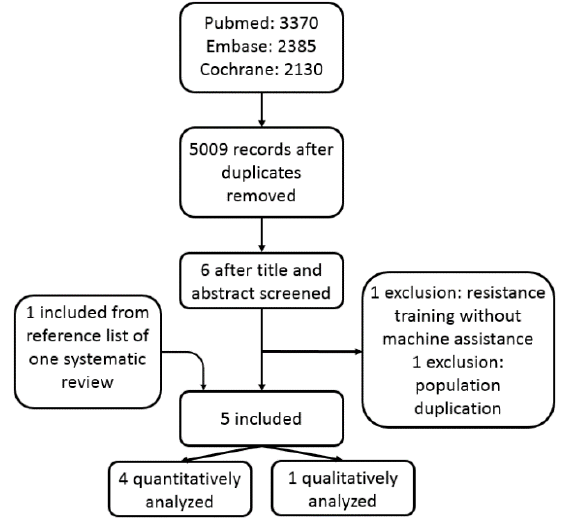
Figure 1. The flowchart of study inclusion.